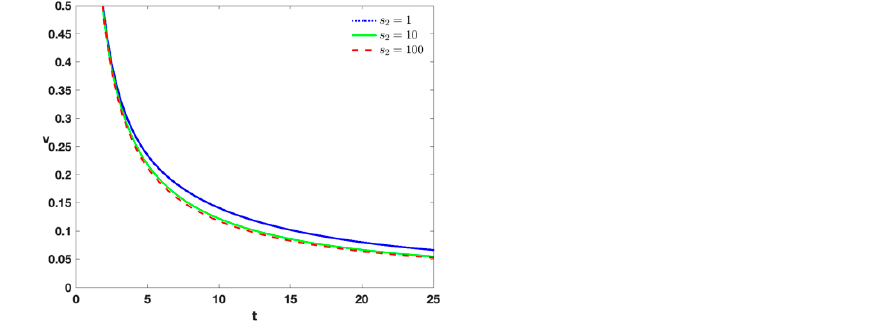
= 1, k = 0.5, b = 1, c = 3, d = 2.5, k 1 1